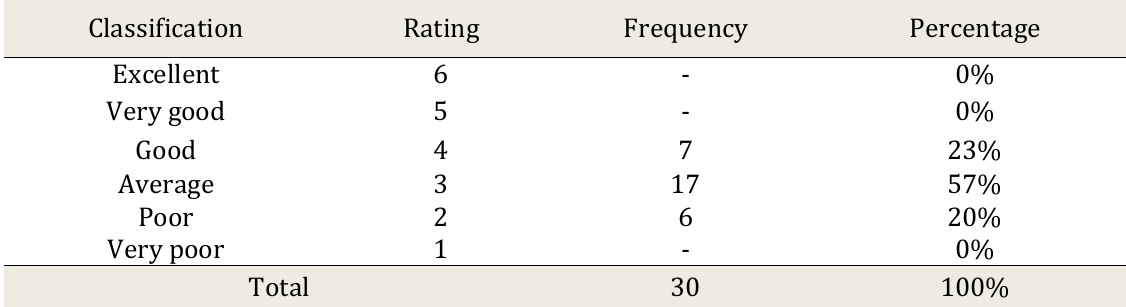
Table 4.24 The Rate Percentage Score of Students' Comprehensibility in Posttest Result in